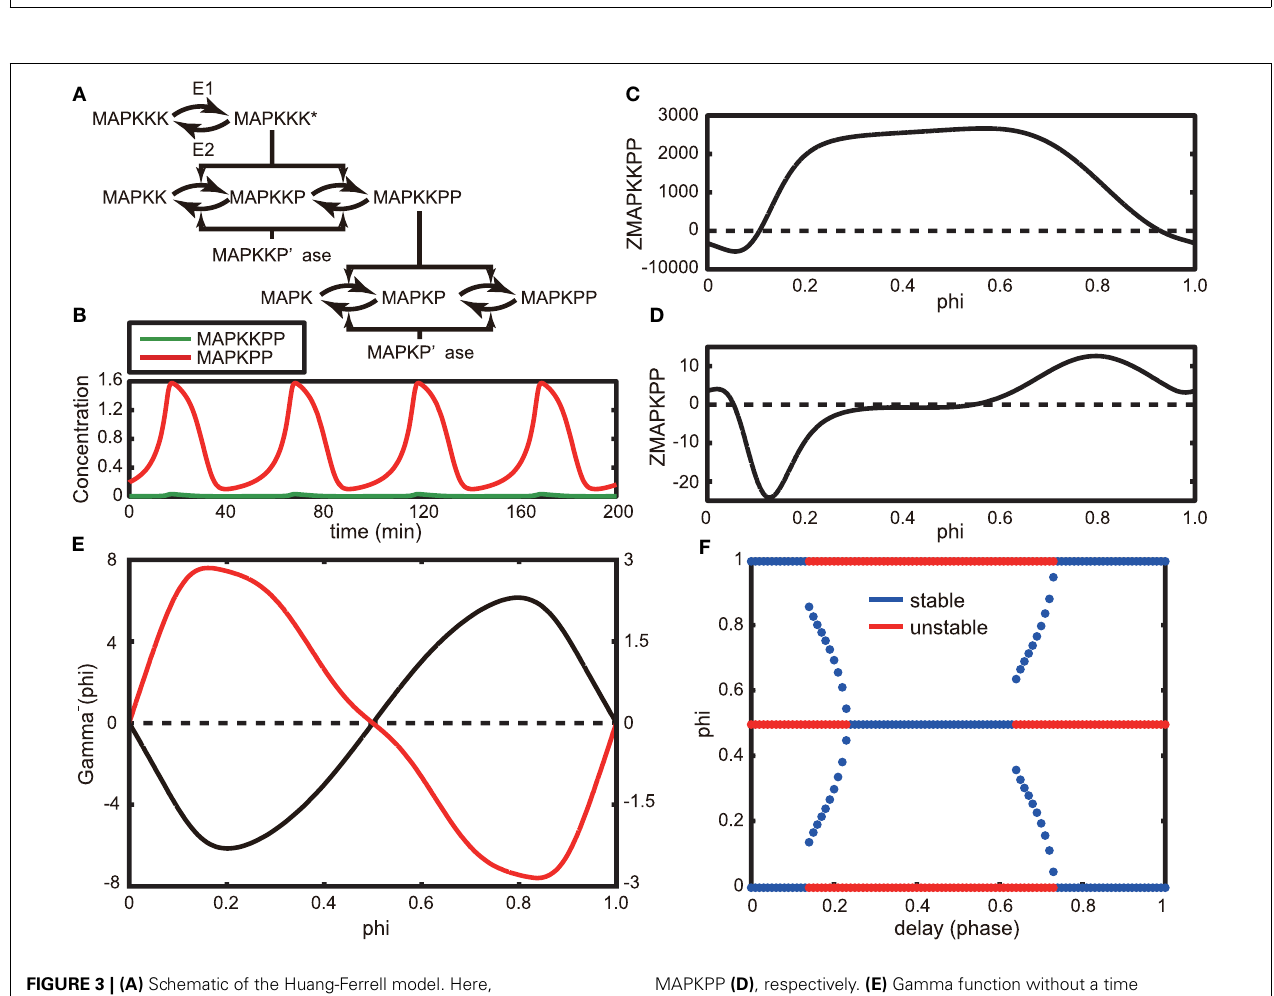
FIGURE 3 | (A) Schematic of the Huang-Ferrell model. Here, MAPKKK* indicates the activation form of MAPKKK. (B) Oscillatory behaviors of MAPKPP and MAPKPP in the steady state of the model. (C,D) Phase response functions of MAPKPP (C) and